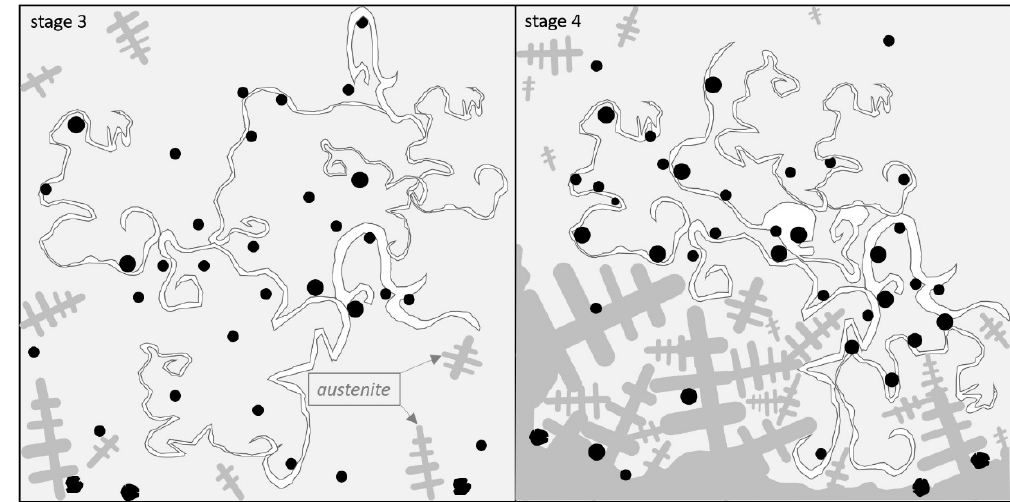
Figure 7. Graphite eutectic system growth in the bifilm environment step by step ( stage 3 and satge 4 ).